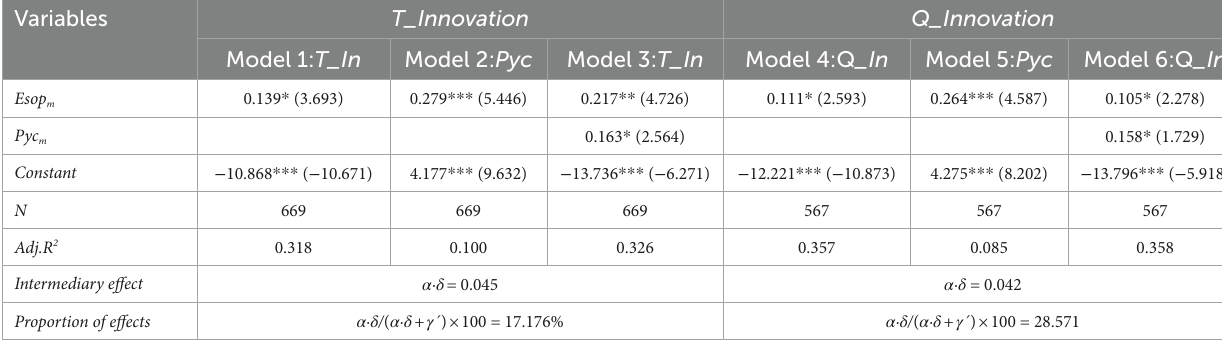
TABLE 8 Verification of the intermediary effect of senior executives’ psychological capital. Variables